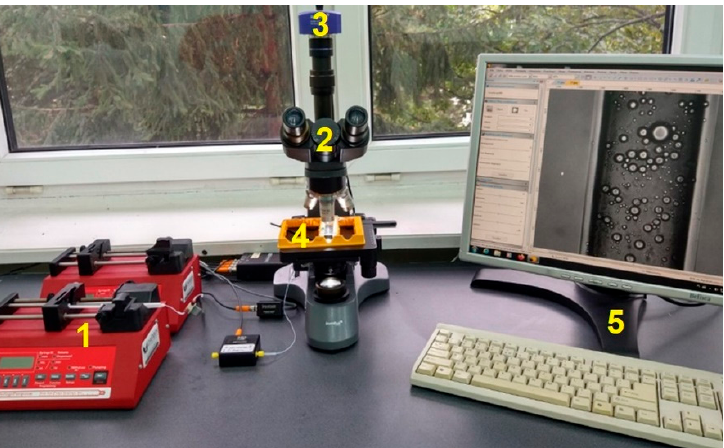
Figure 2. Photo of the test stand.